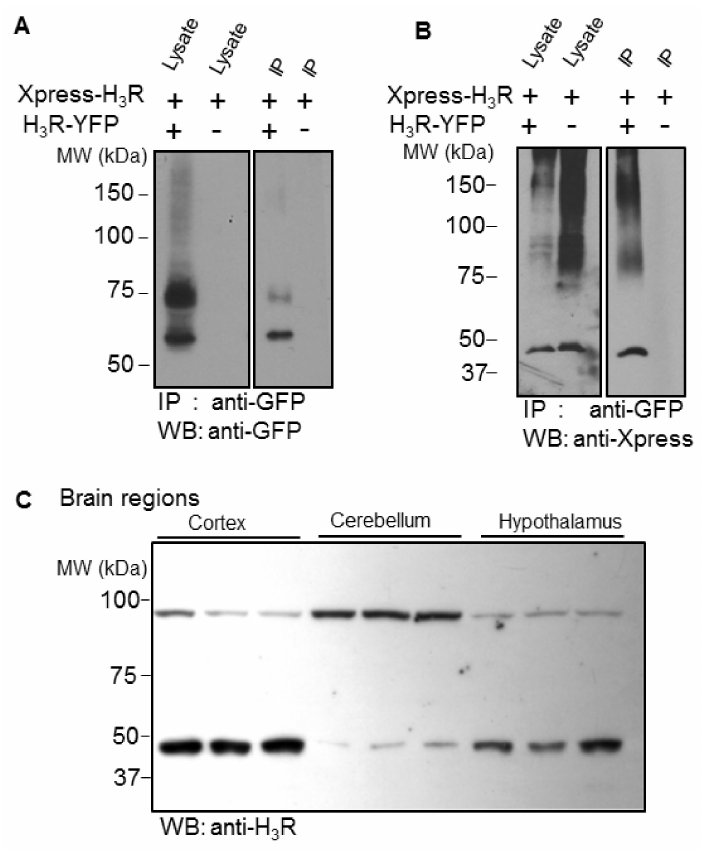
Figure 1. Detection of H 3 R dimers in HEK293 cells and rat brain regions. The Xpress-tagged H 3 receptor (Xpress-H 3 R) was expressed transiently in HEK293 cells in the presence or absence of H 3 R-YFP. Cell lysates were immunoprecipitated using GFP-Trap agarose beads ( A , B ). Lysates or immunoprecipitates (IP) were separated by SDS/PAGE on 8% ( A ) or 10% ( B ) gels. Analysis was performed by Western blot (WB) using a polyclonal anti-GFP antibody ( A ) and a monoclonal anti- Xpress antibody ( B ). Membranes from rat cerebral cortex, cerebellum, and hypothalamus were separated by a NuPAGE 7% Tris-acetate gel system and analyzed by Western blot using the anti-H 3 R antibody ( C ). Similar results were obtained using three different lysates from each brain region.